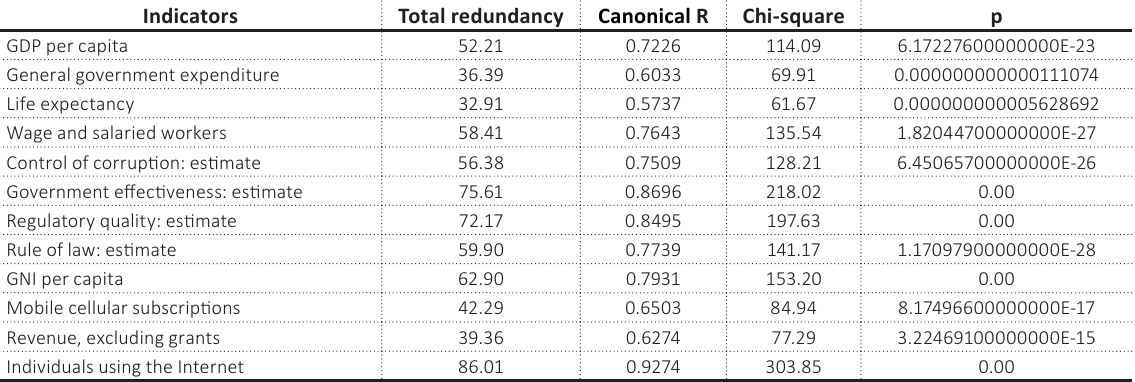
Table 3. Results of canonical